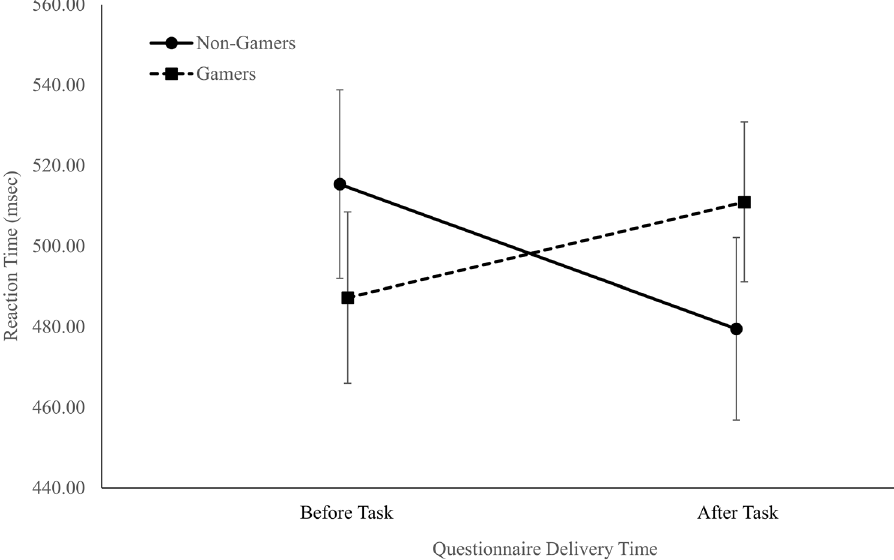
Figure 2. The interaction between group (gamers vs. non-gamers) and the questionnaire delivery time (before vs. after the task) of the mean RT during the Simon task (error bars represent 95% confidence intervals) (figure created using Microsoft